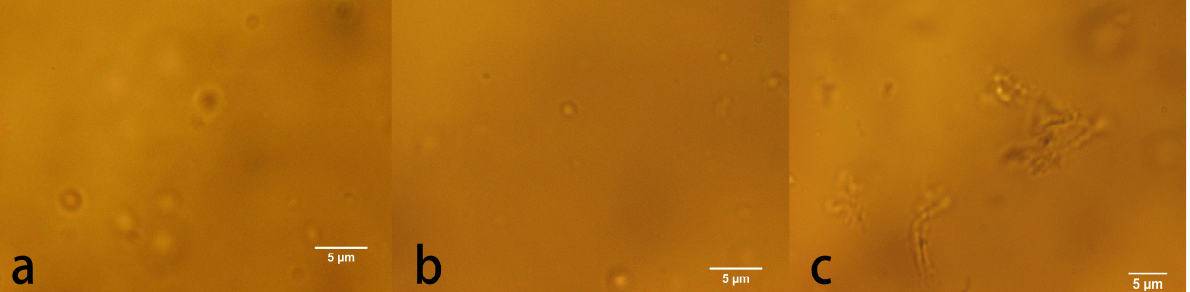
Figure 9. Phase separation of lysozyme under microscope at 25 °C pH 4.8. ( a ) lysozyme concentration 120 mg/mL, NaCl 4%; ( b ) lysozyme concentration 60 mg/mL, NaCl 2%; ( c ) lysozyme concentration 20 mg/mL, NaCl 8%.